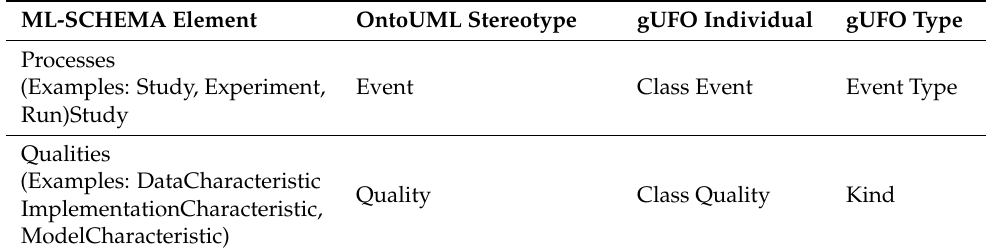
Table 1. Examples of the correspondences of ML-SCHEMA components to OntoUML and gUFO taxonomy of individuals and taxonomy of types. ML-SCHEMA Element OntoUML Stereotype gUFO